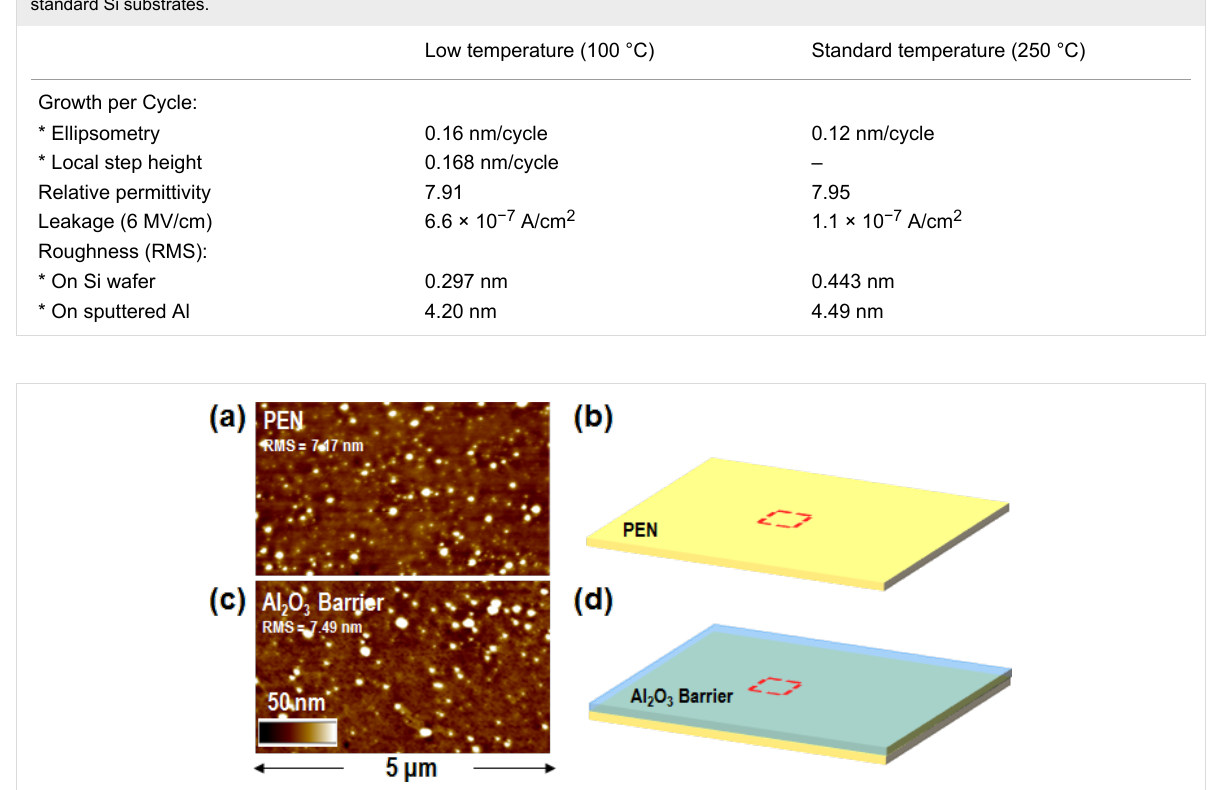
Table 1: Comparison between the low temperature and standard temperature process properties extracted during the material characterization on the standard Si substrates.